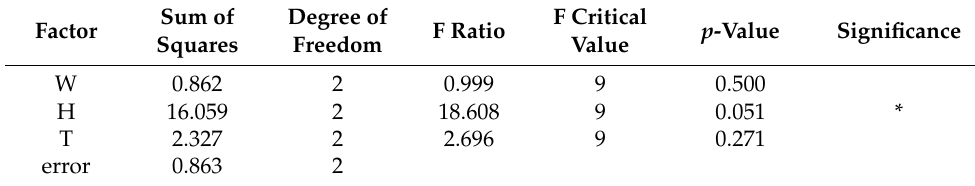
Table 3. Variance analysis of weight loss rate of impregnated heat-treated wood.